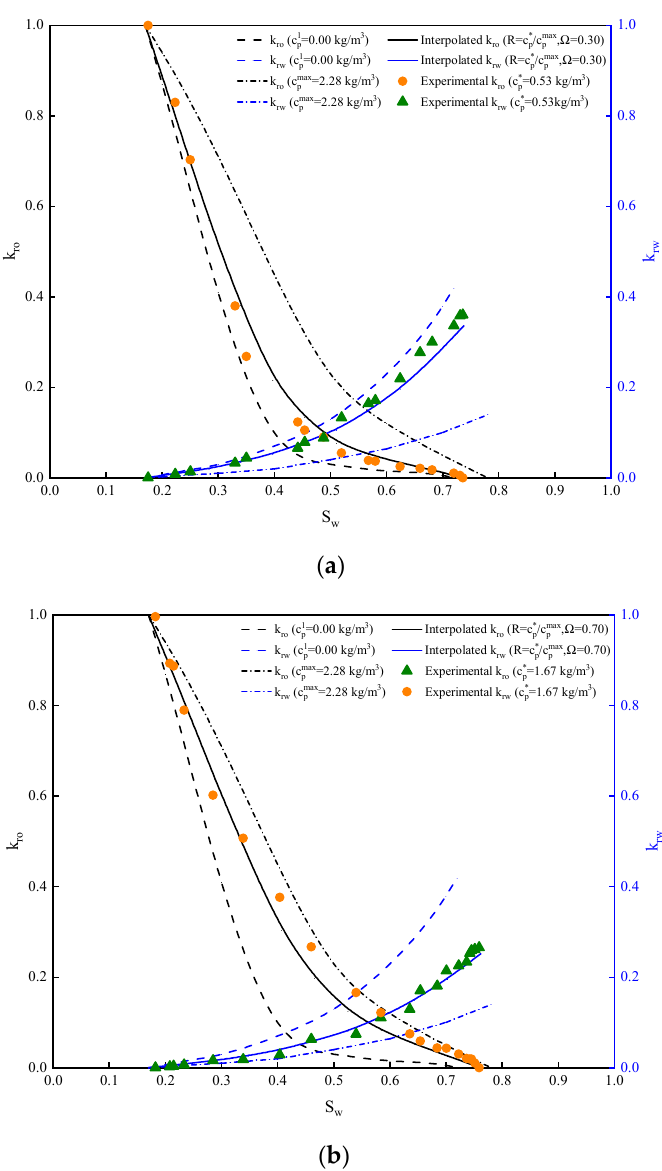
Figure 4. The validation of the relative permeability curve’s interpolation in the polymer flooding. ( a ) c p = 0.53 kg/ m 3 ( b ) c p = 1.67 kg/ m 3